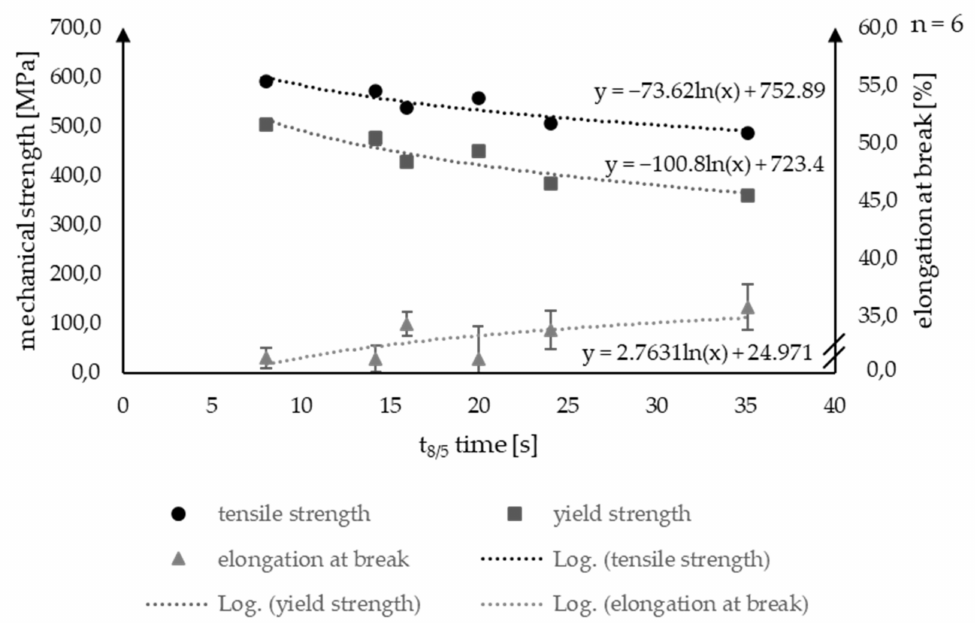
Figure 10. Tensile, yield strength and elongation at break as a function of t 8/5 cooling time from measured